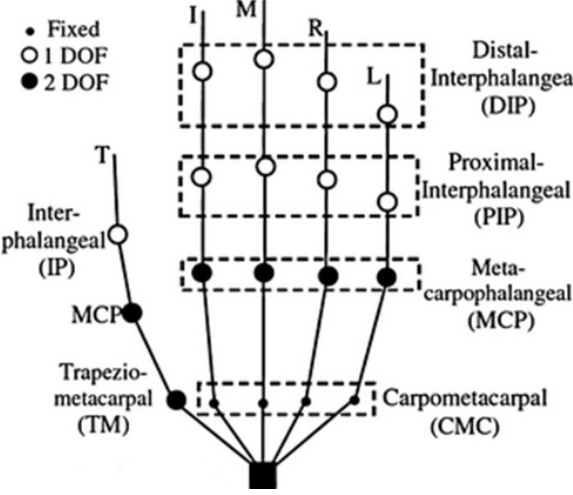
Figure 1: Human hand model.